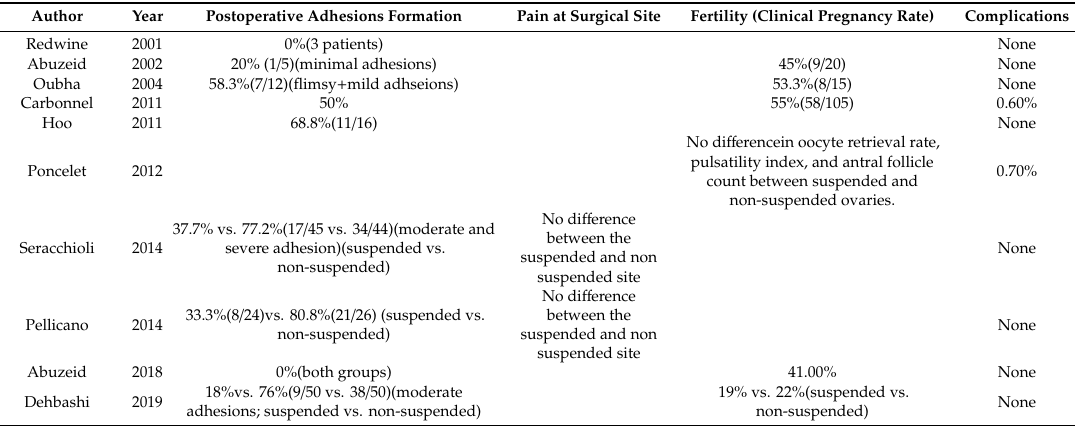
Table 2. Summary of various factors in relation to